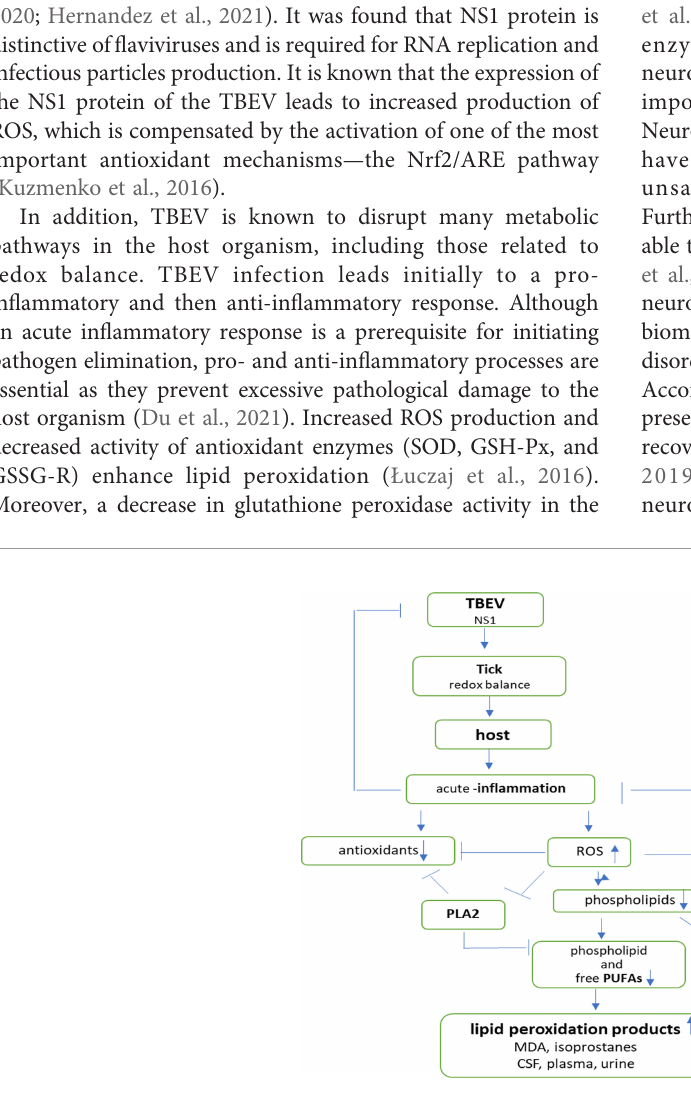
FIGURE 5 | Effects of pathogen – vector – host interactions in TBE